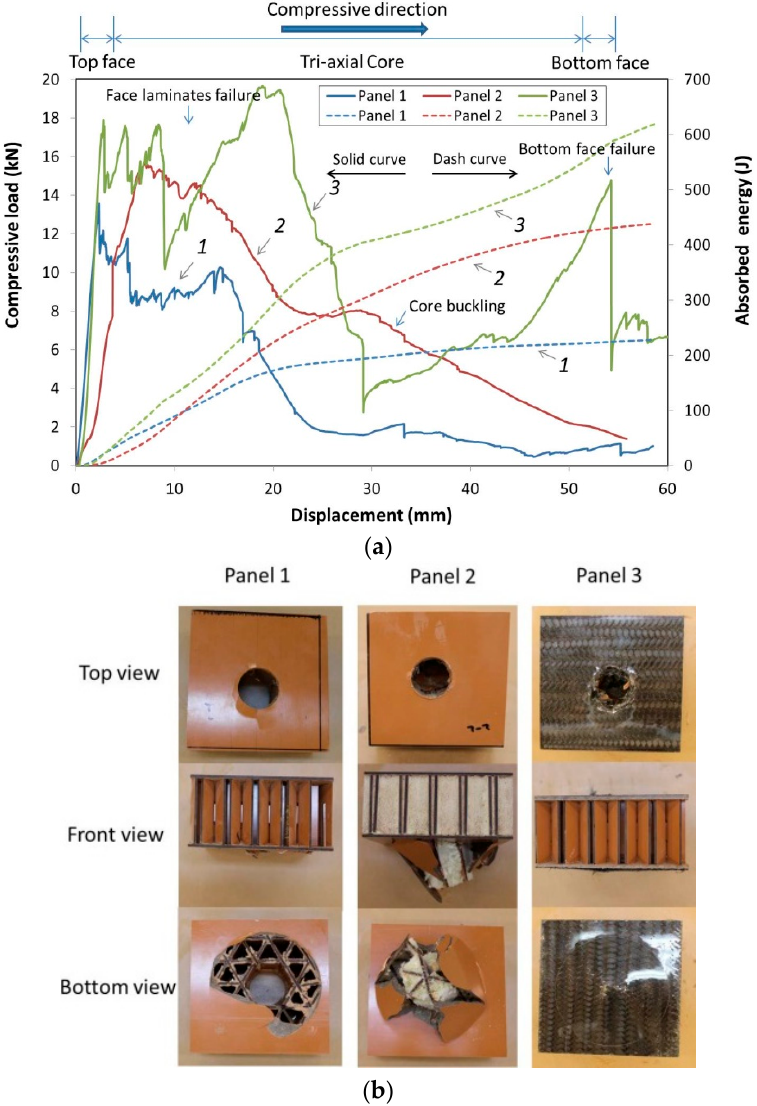
Figure 3. ( a ) Typical load and absorbed energy vs. displacement curves of panels in the quasi-static compression; ( b ) Typical failure modes of panels in the quasi-static compression.